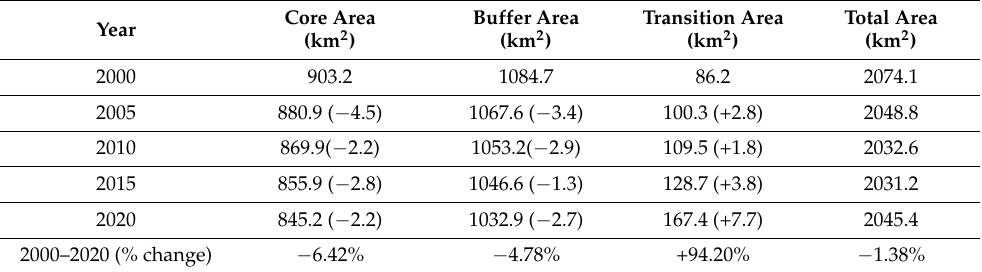
Table 1. The Indian Sundarbans mangrove forest area over time. Numbers in parenthesis show average annual change over the proceeding five years, with negative indicating loss and positive indicating